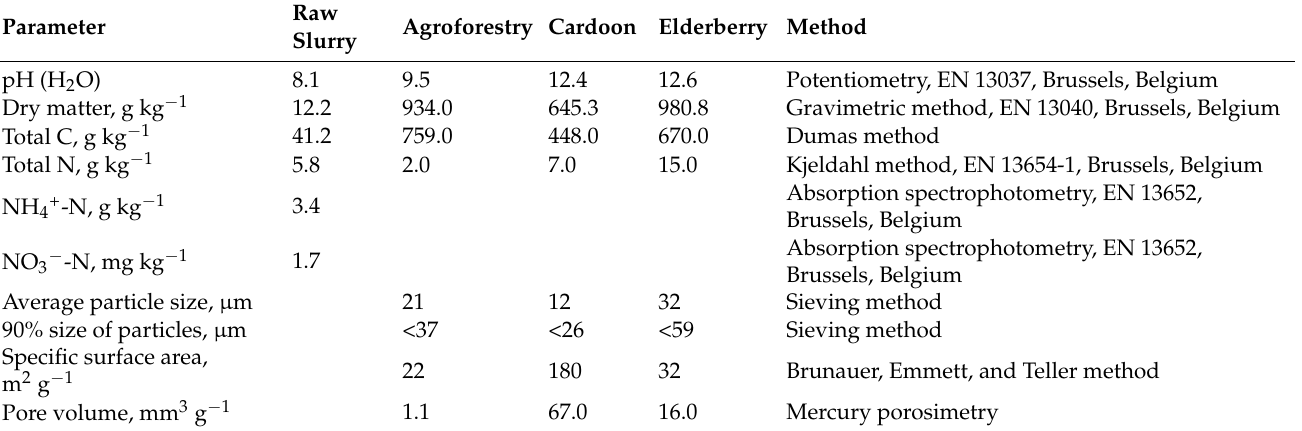
Table 1. Composition of the pig slurry and biochars used in the experiment ( n =